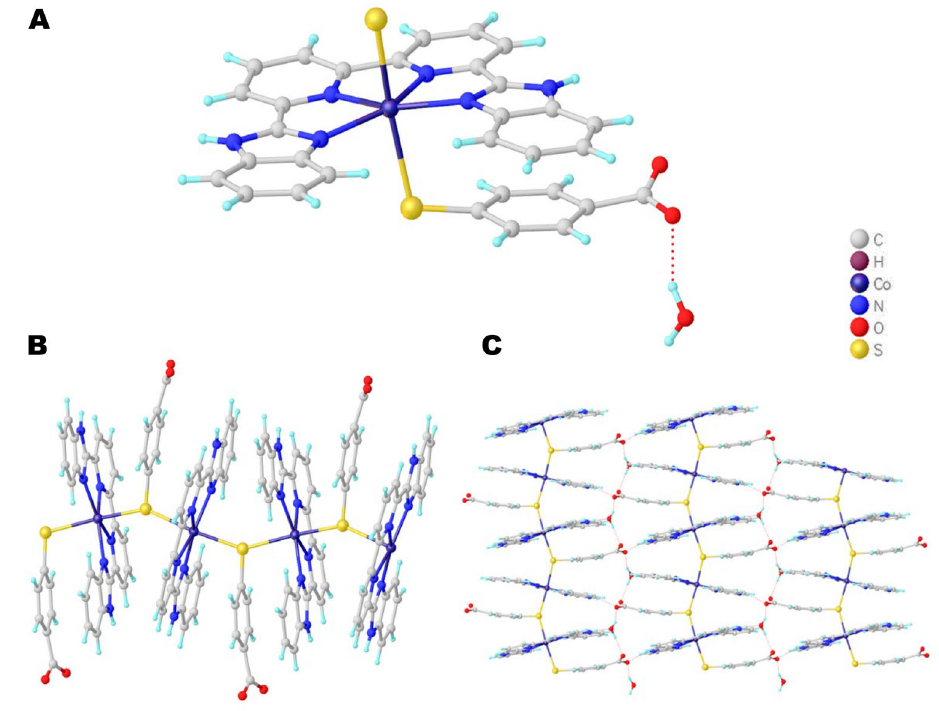
Figure 3. A , Molecular unit of complex 2. B , 1D chain-like network for complex 2. C , 3D supramolecular unit of complex 2 via H-binding